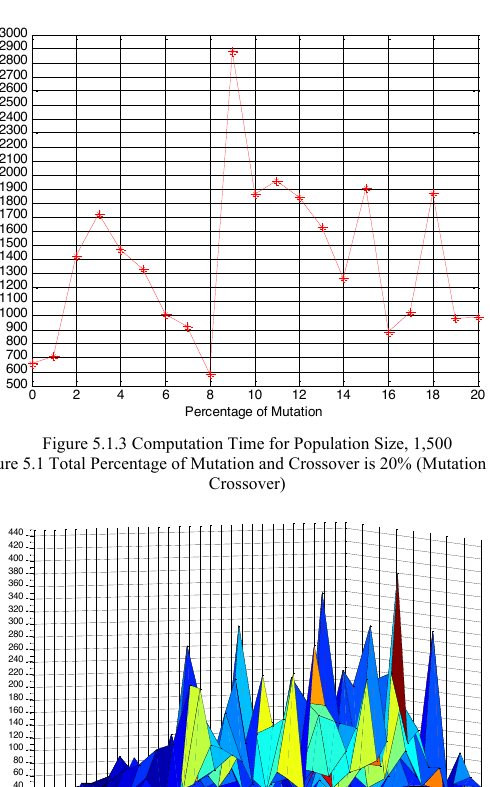
Figure 5.3.2 Computation Time when Total Percentage is 40%